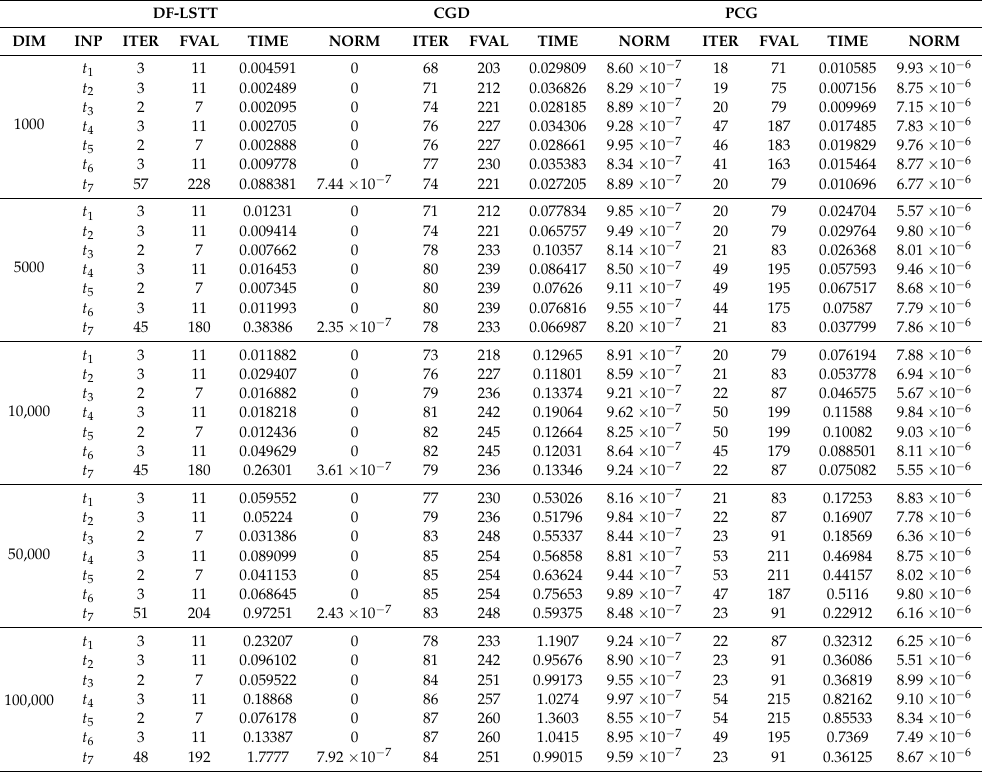
Table 6. Numerical test reports for the three tested methods for Problem 4.